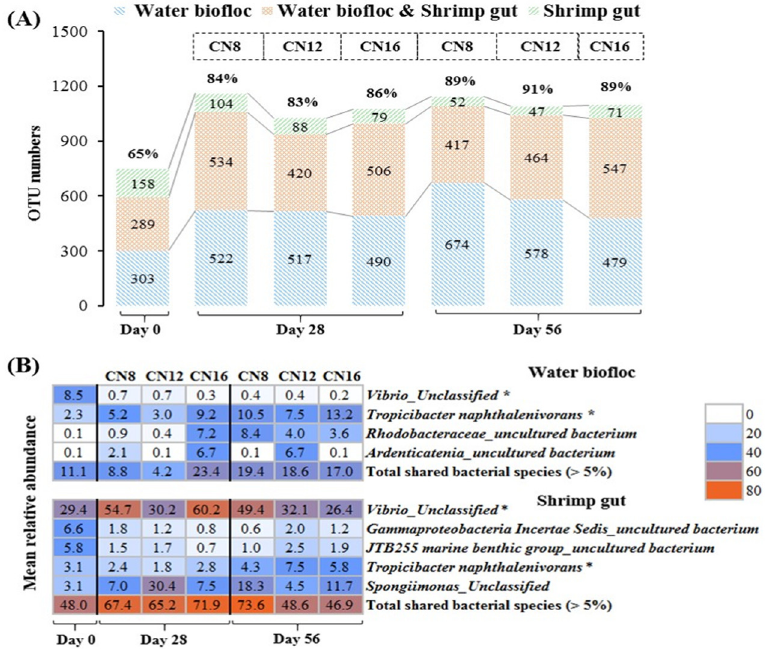
Figure 7. OTUs similarity and core bacterial species between water biofloc and shrimp gut from biofloc-based tank systems during an 8-week intensive production trial of P. vannamei with three input C/N ratios (means ± S.D., n = 3). ( A ) The number and similarity of shared and unique bacterial OTUs between water biofloc and shrimp gut. ( B ) The difference in core bacterial species in relative abundance between water biofloc and shrimp gut. Significant difference among the three C/N ratio groups indicated by *.